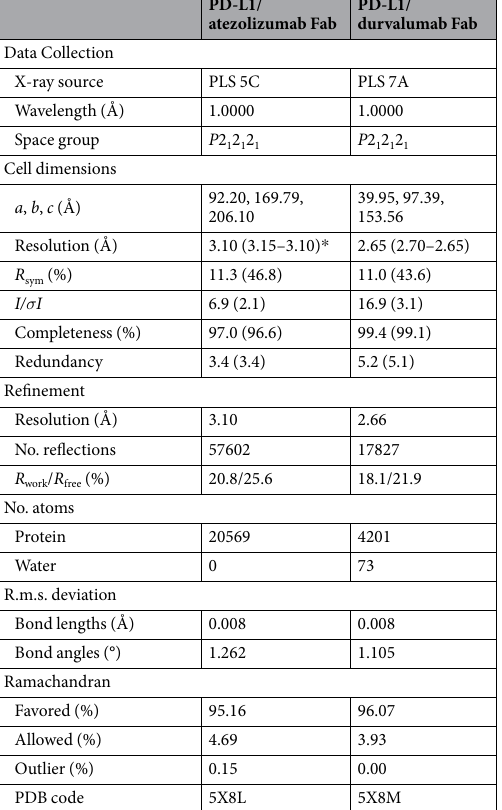
Table 1. Data collection and refinement statistics. * Values in parentheses are for the outer resolution